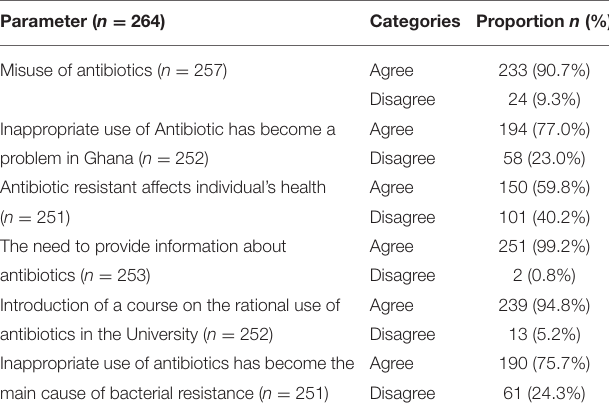
TABLE 4 | Attitude toward antibiotic use among participants.